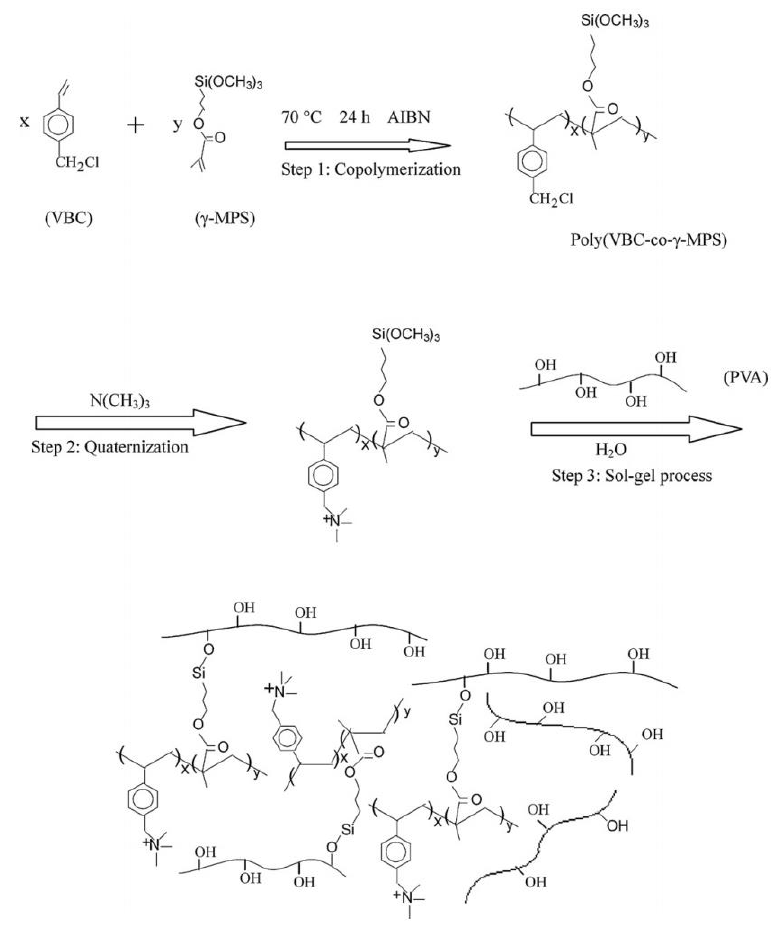
Figure 3. Synthetic routes of hybrid membranes based on poly (VBC-co-MPS) and PVA. Reprinted from Reference [59] with permission from Elsevier.